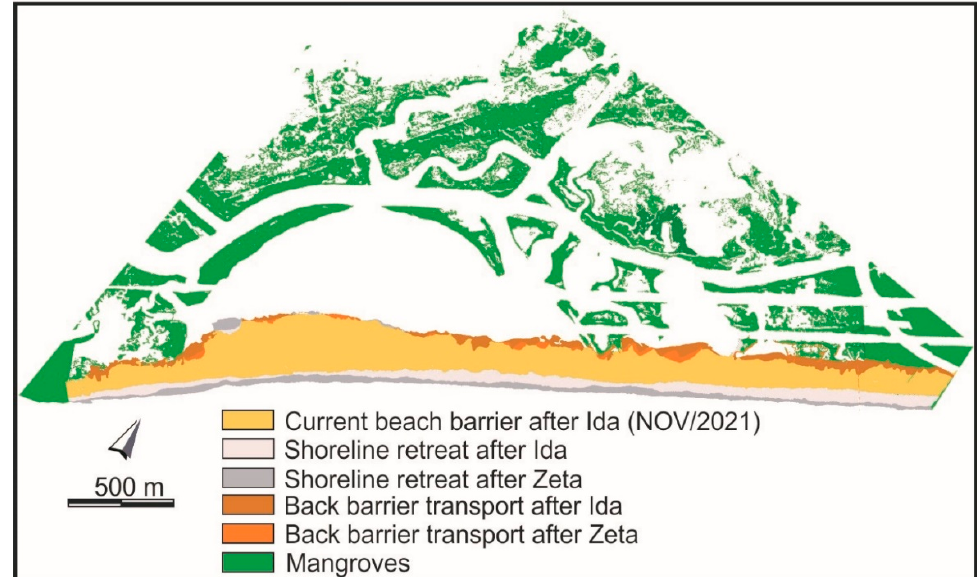
Figure 8. Composite diagram showing beach barrier dynamics associated with Hurricane Ida and Zeta.